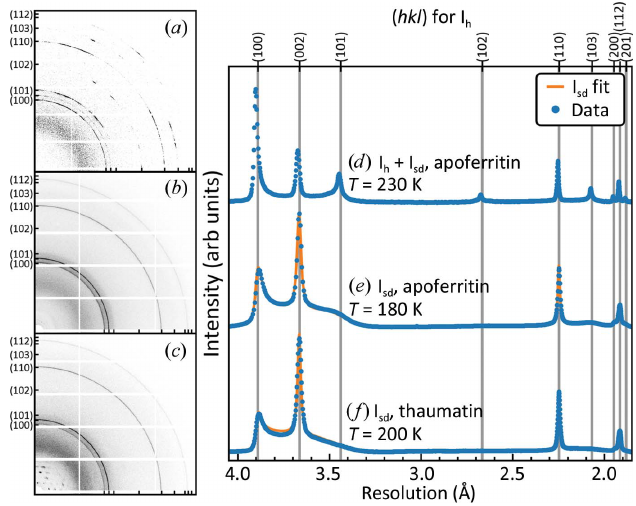
Figure 6 ( a , b , c ) Examples of detector images showing ice diffraction. ( a ) Mixture of hexagonal ice (I h ) and stacking-disordered ice (I sd ) in a glycerol-free apoferritin crystal at 230 K. ( b ) I sd in a glycerol-free apoferritin crystal at 180 K. ( c ) I sd in a glycerol-free thaumatin crystal at 200 K. ( d , e , f ) Dotted blue lines indicate azimuthally integrated and background-subtracted ice- ring diffraction profiles calculated from the detector images in ( a ), ( b ) and ( c ), respectively. The solid orange lines are best-fit profiles calculated using DIFFaX .